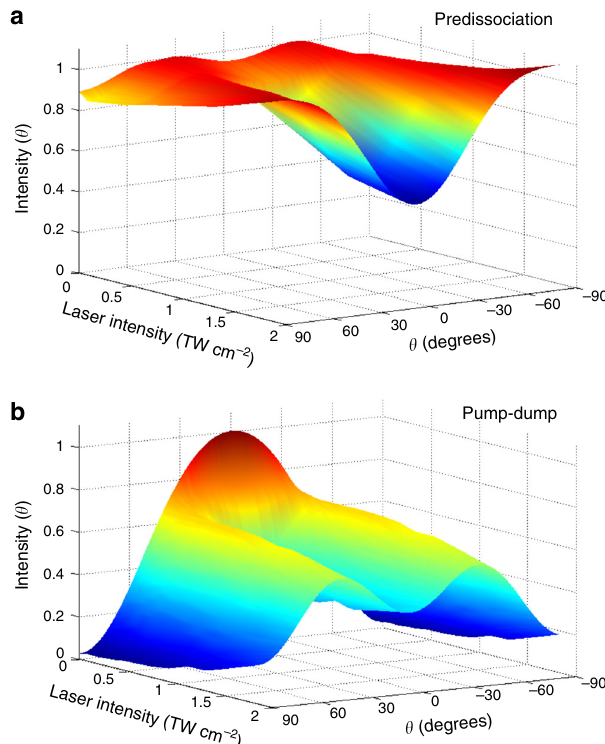
Fig. 4 Dependence of fragment spatial distributions with control laser intensity. Asymptotic angular distributions of the methyl fragment resulting from B -band predissociation of CH 3 I as a function of the intensity of a NIR control fi eld of picosecond duration present during UV excitation. a The top panel corresponds to the main predissociation channel and b the bottom panel to the pump-dump channel For the results shown in the bottom row of Fig. 3, a higher intensity (2.5 TW/cm 2 ) ps-duration NIR fi eld is applied synchronously with excitation. The image in Fig. 3c is the corresponding asymptotic Abel-inverted methyl fragment image.